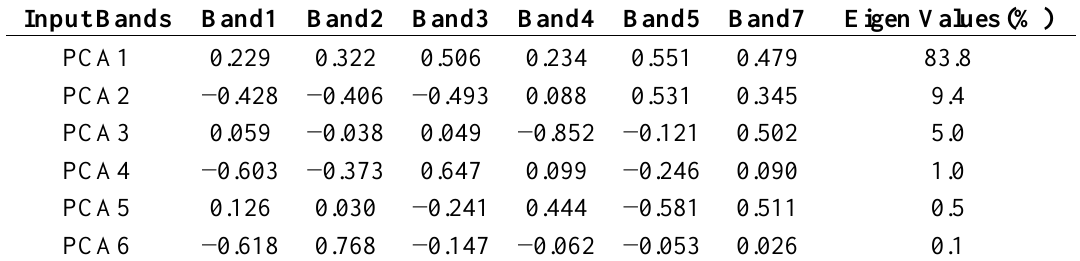
Table 1. Eigenvector matrix of the principal component analysis for the six Landsat 7 Landsat Enhanced Thematic Mapper (ETM+) bands studied.